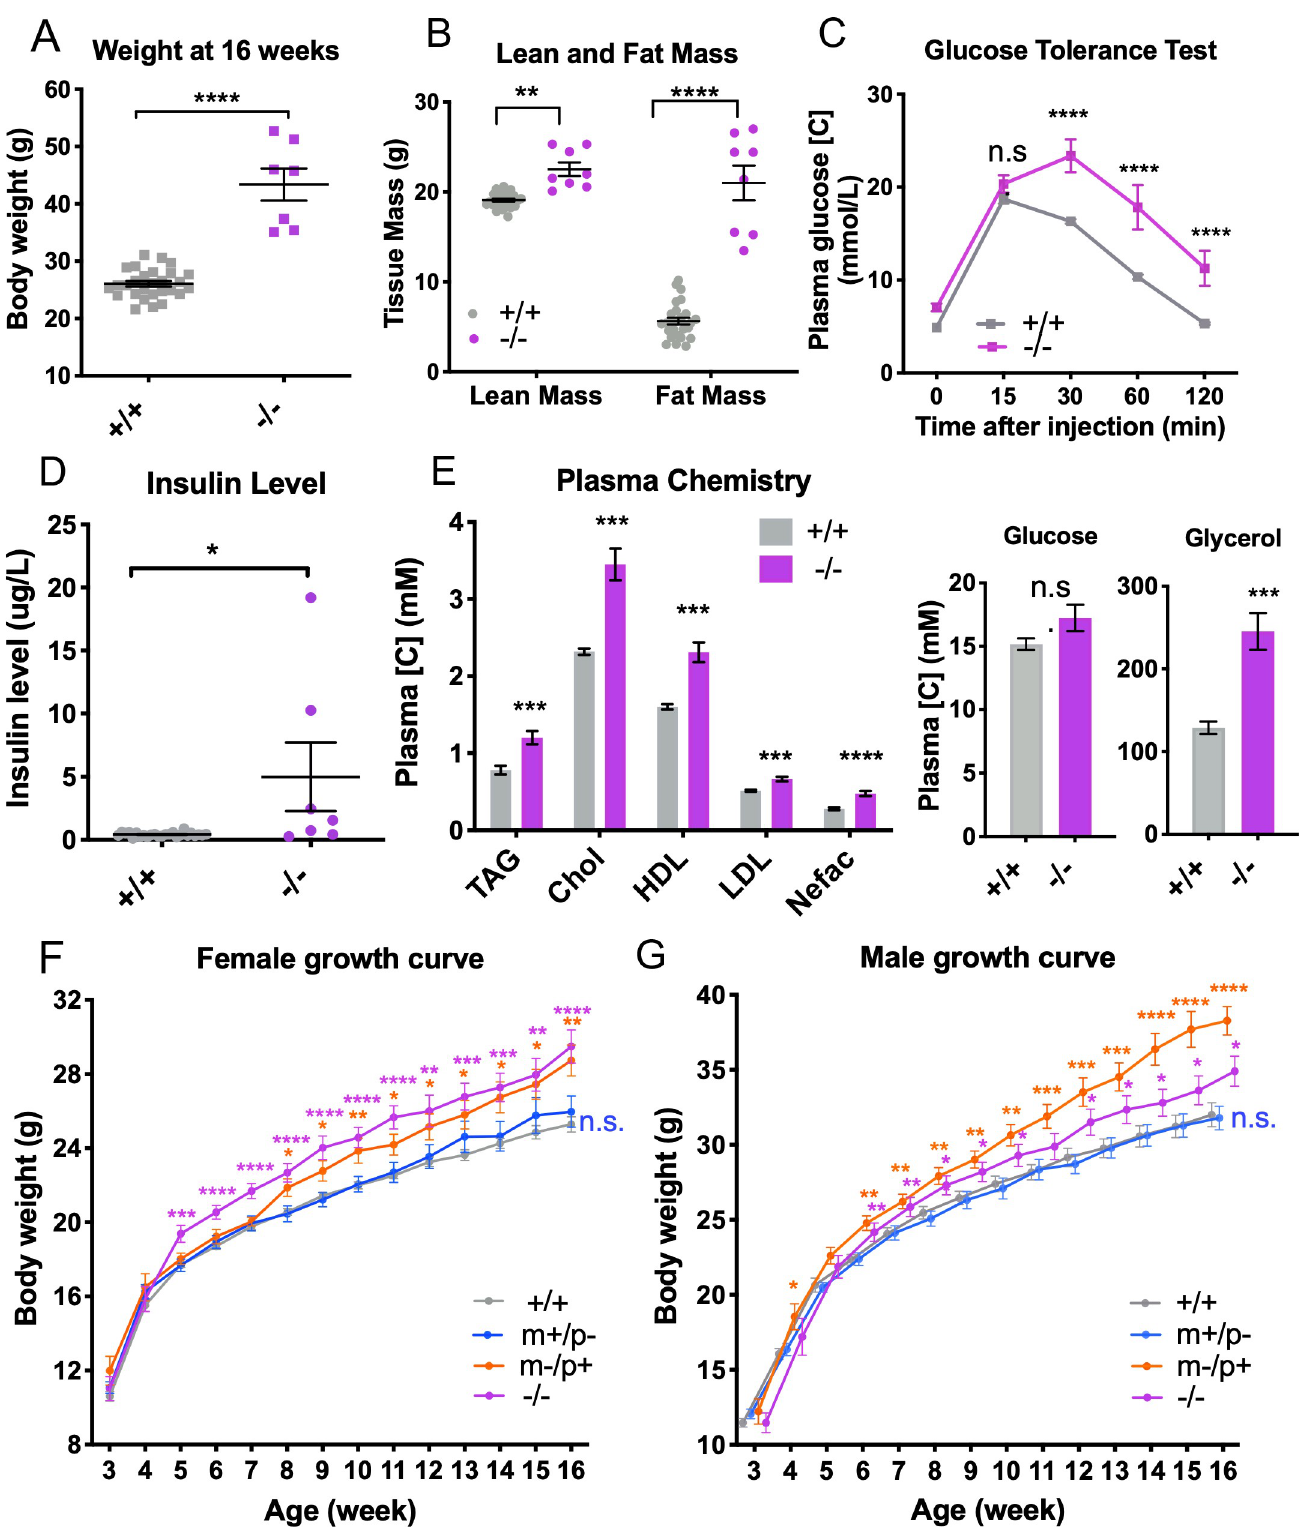
Fig 6. Trappc9 deficient mice show a parent-of-origin-dependent obesity phenotype. (A-E) Female Trappc9 -/- mice (-/-, n = 8, age = 16 weeks) showed increased body weight (A), increased lean mass and fat mass (B), glucose intolerance (C), increase blood insulin levels (D) and levels of triacylglycerol (TAG),